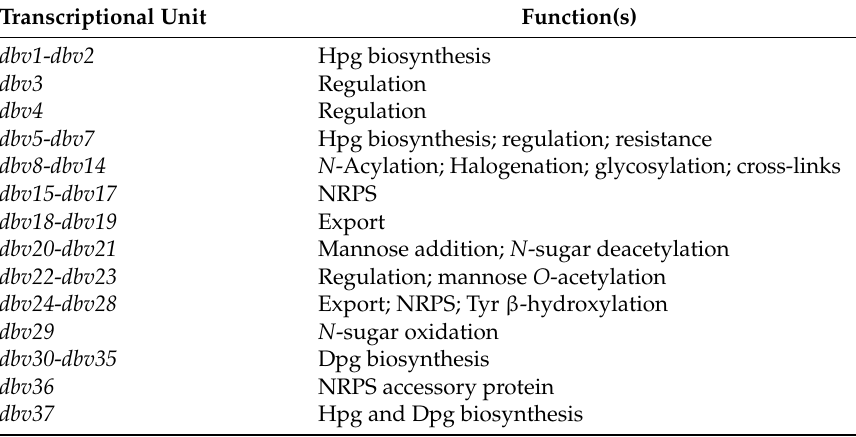
Figure 2. Genetic organization of the dbv cluster. The thin black arrows indicate experimentally determined operons. Red triangles indicate experimentally determined Dbv4 binding sites, with the corresponding transcripts as red thick arrows; the thin green arrows represent the transcriptional units controlled by Dbv3. The dbv genes are grouped by functional category as indicated. See also Table 1. Table 1. Transcriptional units and biosynthetic roles of the corresponding